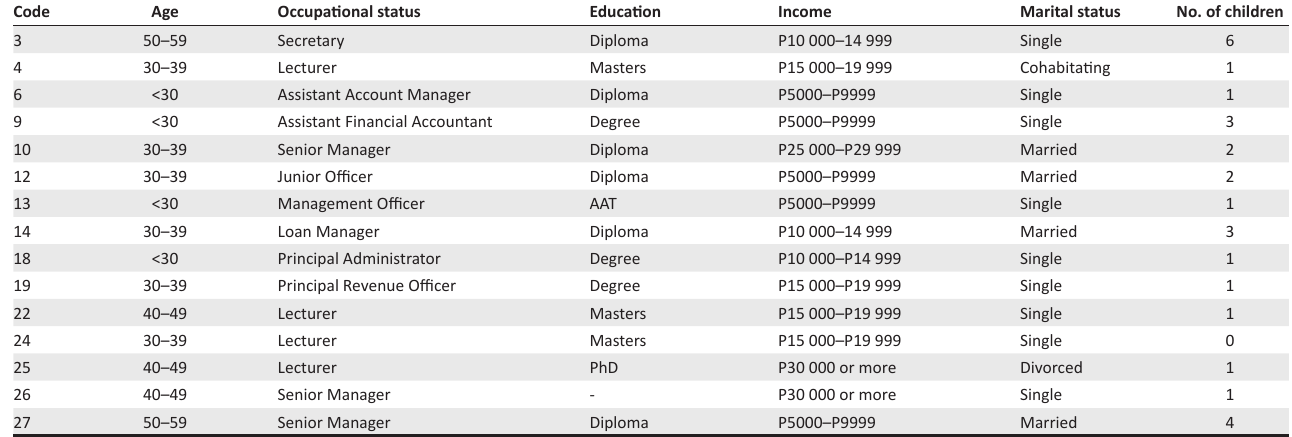
TABLE 1-A2: Profile of female